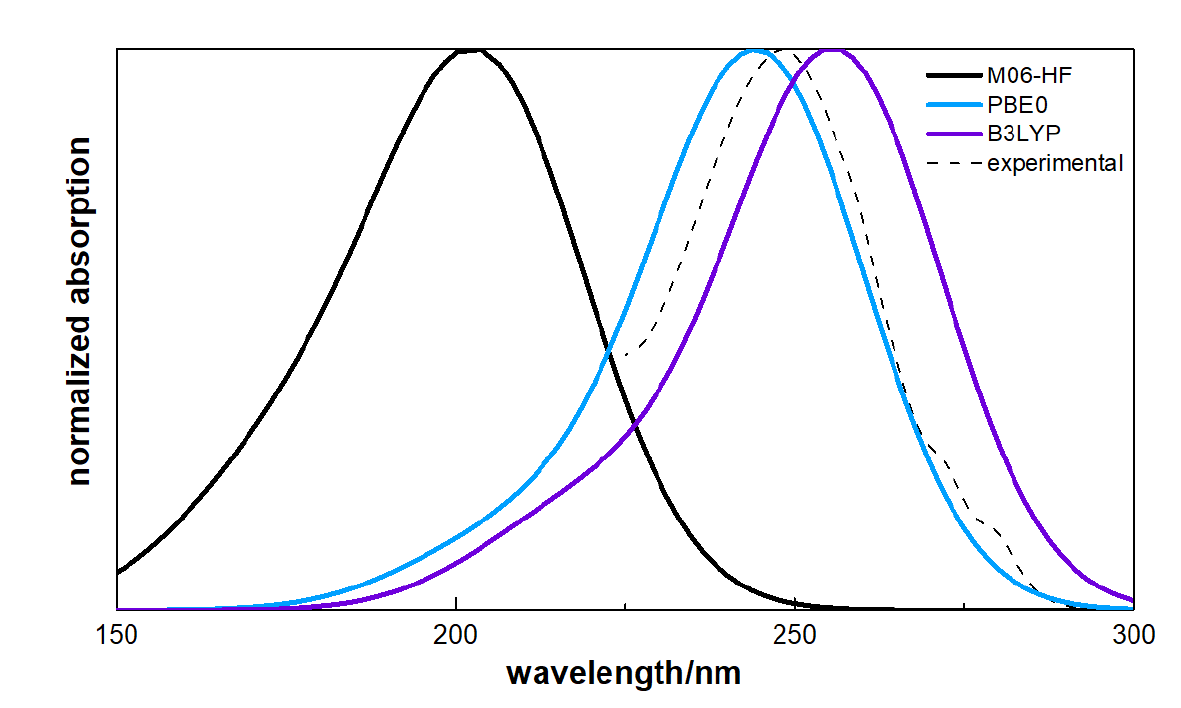
Figure 4. UV spectra for the ground-state of ATZ using the TDDFT/VDZ basis set with the Tamm–Dancoff approximation. For comparison the experimental result is also shown. Both experimental data and theoretical results have been obtain considering methanol as the